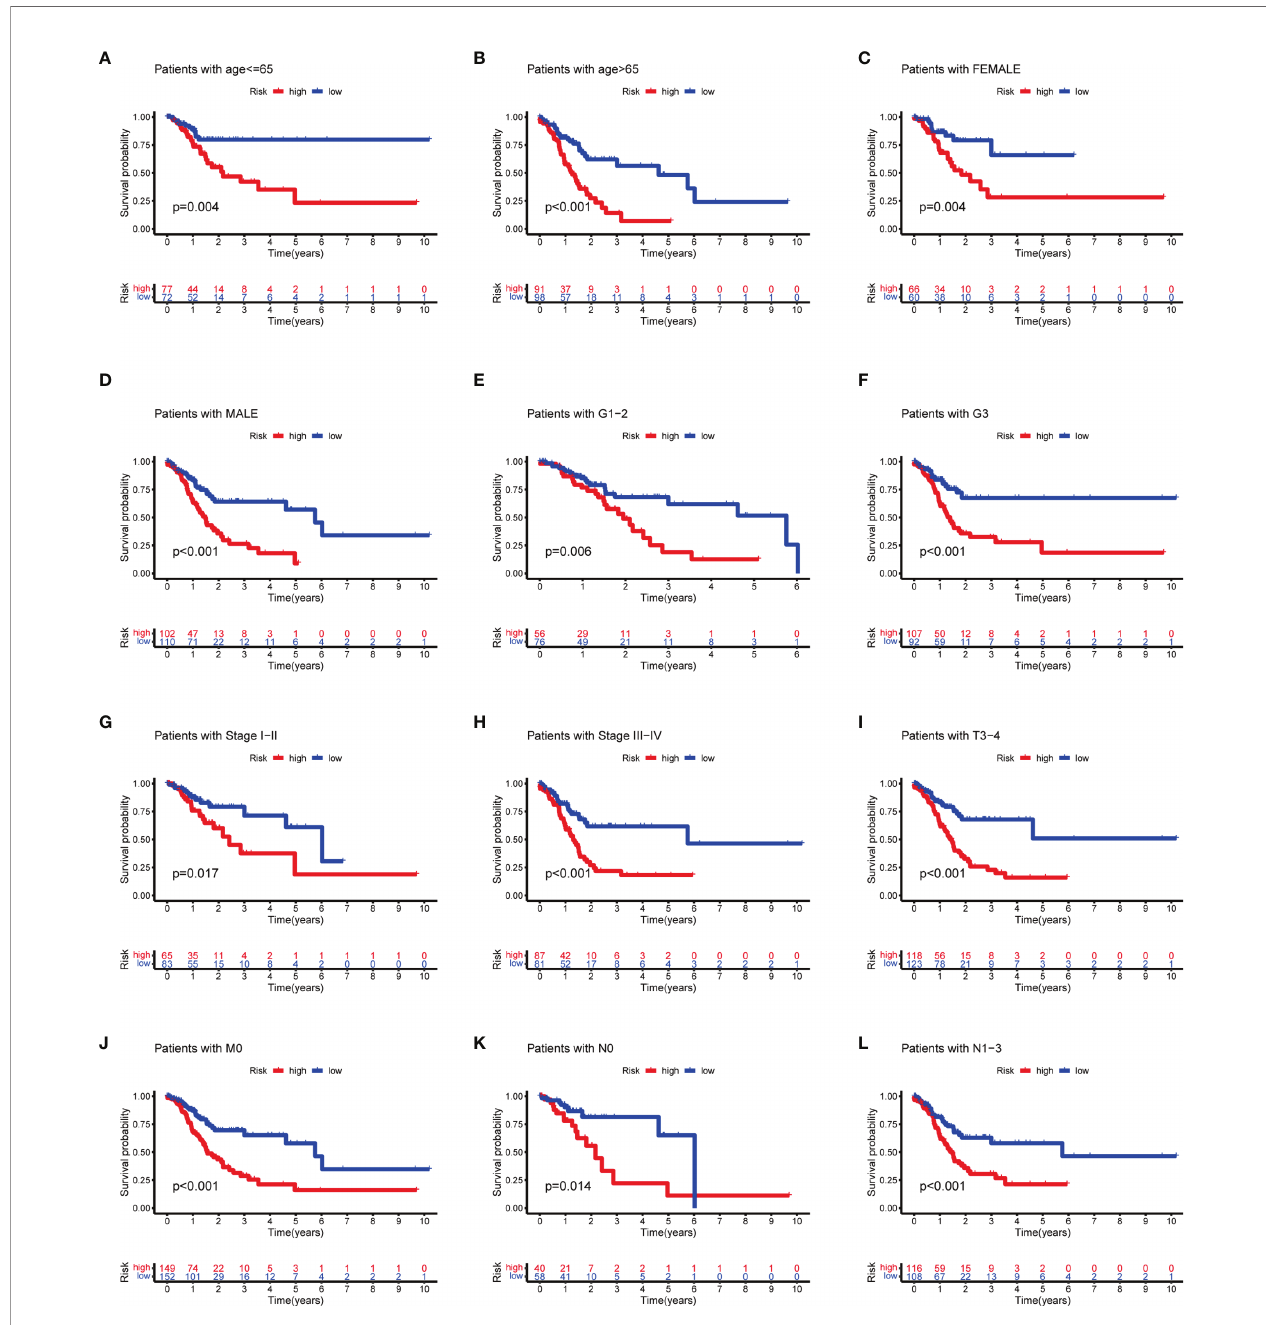
FIGURE 8 | Subgroup analysis with different clinicopathological features in STAD: (A) age ≤ 65; (B) age >65; (C) female; (D) male; (E) G1 – G2; (F) G3; (G) stages I – II; (H) stage III – IV; (I) T3 – T4; (J) M0; (K) N0; and (L)